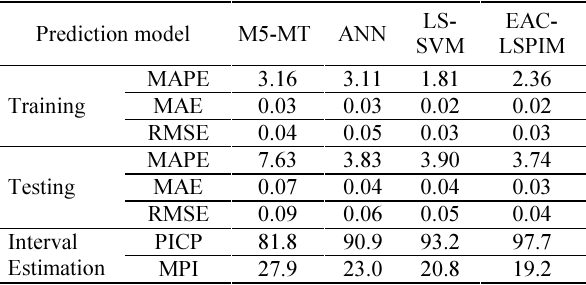
Table 7. Prediction result comparison for 2 testing projects Prediction model